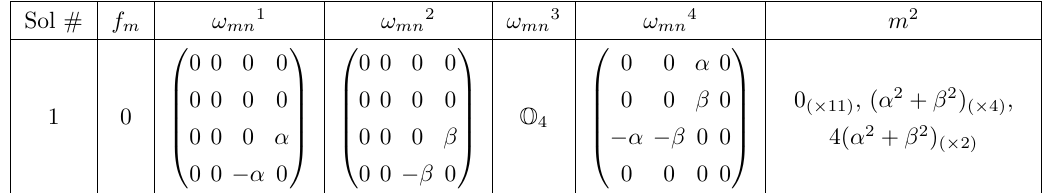
Table 25 . Some critical points of the scalar potential induced by the compacti(cid:12)cation of IIB with O9/D9. In this case, we show a 2-parameter family of solutions, all of them corresponding to Minkowski